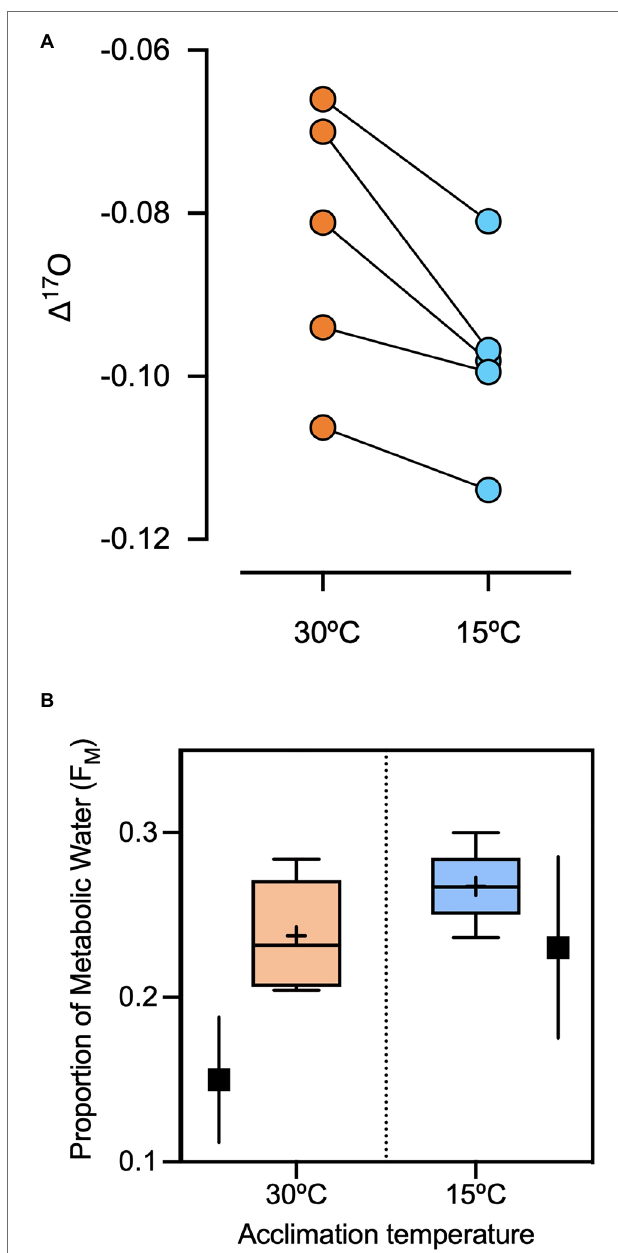
FIGURE 2 | (A) The effects of changes in metabolic rate and water intake on Δ' 17 O values of five Z. capensis . Individuals were kept in standard housing conditions at 30 ° C, then exposed to 15 ° C for 15 days. The cooler temperature, outside of their thermal neutral zone, induced increases in RMR by a mean (± SD ) of 31% ± 12% (data not shown) and decreases in mean drinking water intake ( − 17% ± 28%). These changes should have increased the contribution of metabolic water to the body water pool. Accordingly, the Δ' 17 O values of plasma samples significantly declined from 30 ° C to 15 ° C, reflecting the greater contribution of metabolic water ( Δ' 17 O = − 0.44‰) and smaller contribution of drinking water ( Δ' 17 O = 0.03‰). (B) The mean proportion of metabolic water in the body water pool water in captive Z. capensis estimated from Δ' 17 O of plasma at 15 ° C and 30 ° C ambient temperature. Values from physiological experiments (W IM /(W IM + W D ) are included in filled black squares and its error for